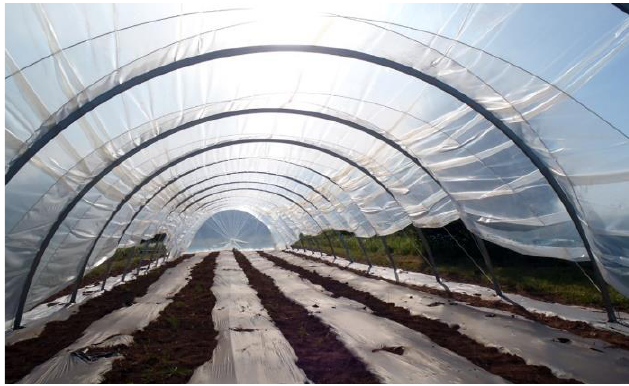
Figure 15. Greenhouse covering. Reprinted from website [89].